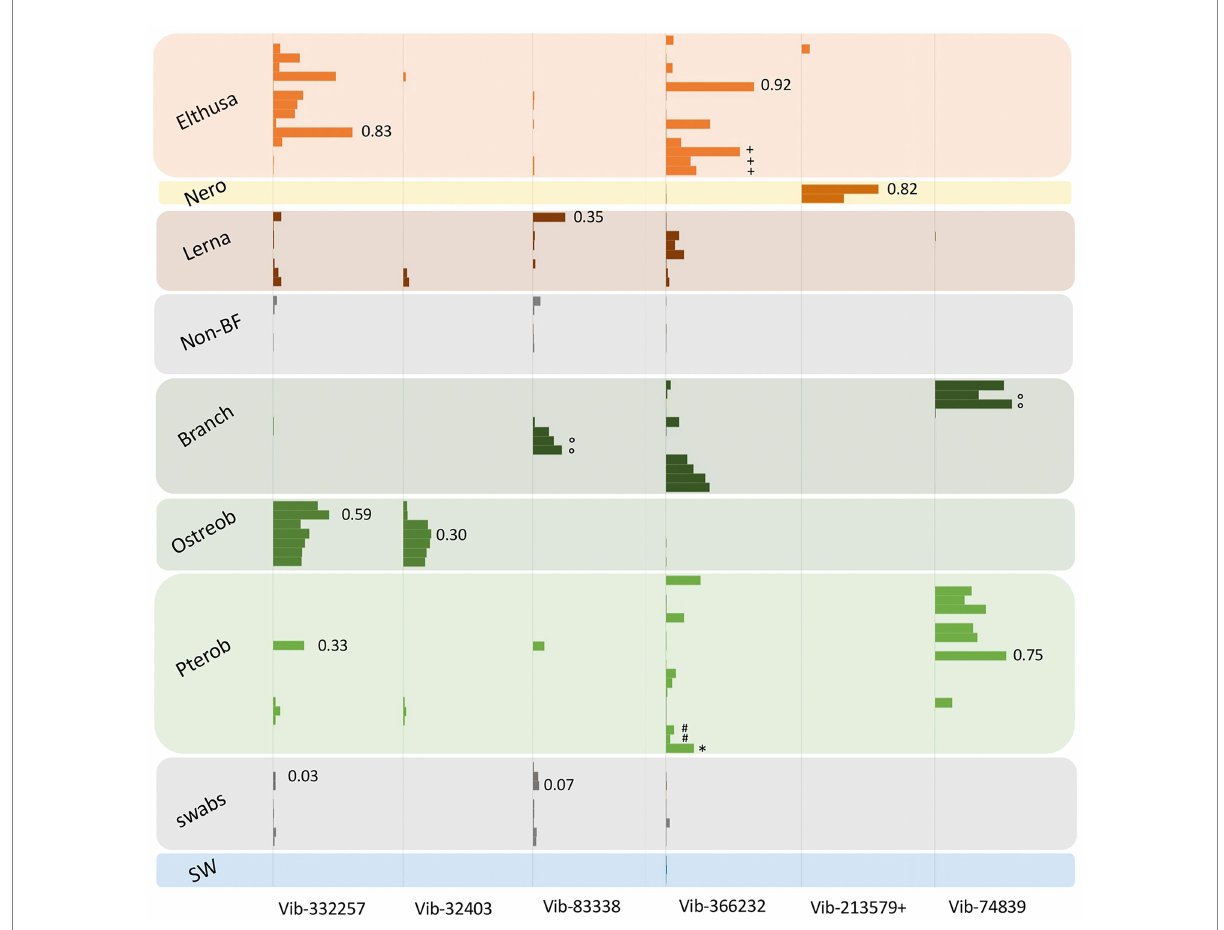
FIGURE 3 Relative abundances of the 7 most prevalent Vibrio ribotypes (based on 99% 16S rRNA gene sequence similarity) from obligate marine blood- feeders including the isopods Elthusa and Nerocila (Nero), copepod Lernanthropus (Lerna), and leeches Branchellion, Ostreobdella, and Pterobdella, compared to non-blood-feeding crustaceans (Non-BF), swabs of fish skin, and seawater (SW). Bars are scaled according to percent abundance of each Vibrio ribotype as a function of the entire microbial community in that specimen (for reference, occasional numbers indicate the % abundance of that bar). A total of 135 Vibrionaceae ribotypes were recovered from all samples in total, but the 7 portrayed here accounted for 80% of the total Vibrionaceae diversity. See Supplementary Figure S1 for the phylogenetic position of these ribotypes. Note the pooling of Vibrio ribotypes 19,850 with 213,579 (+) common only in the Nerocila specimens via amplicon sequencing. Occasional symbols note distinction within OBF taxa, including Pterobdella occidentalis recovered from the goby (#), and P. abditovesiculata from Hawaii (*), as well as Branchellion collected from rays other than the pacific ray ( ° ), and Elthusa collected from killifish